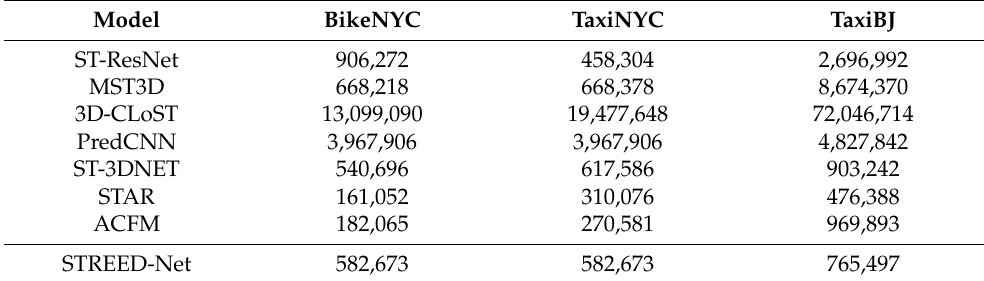
Table 5. Number of trainable parameters.